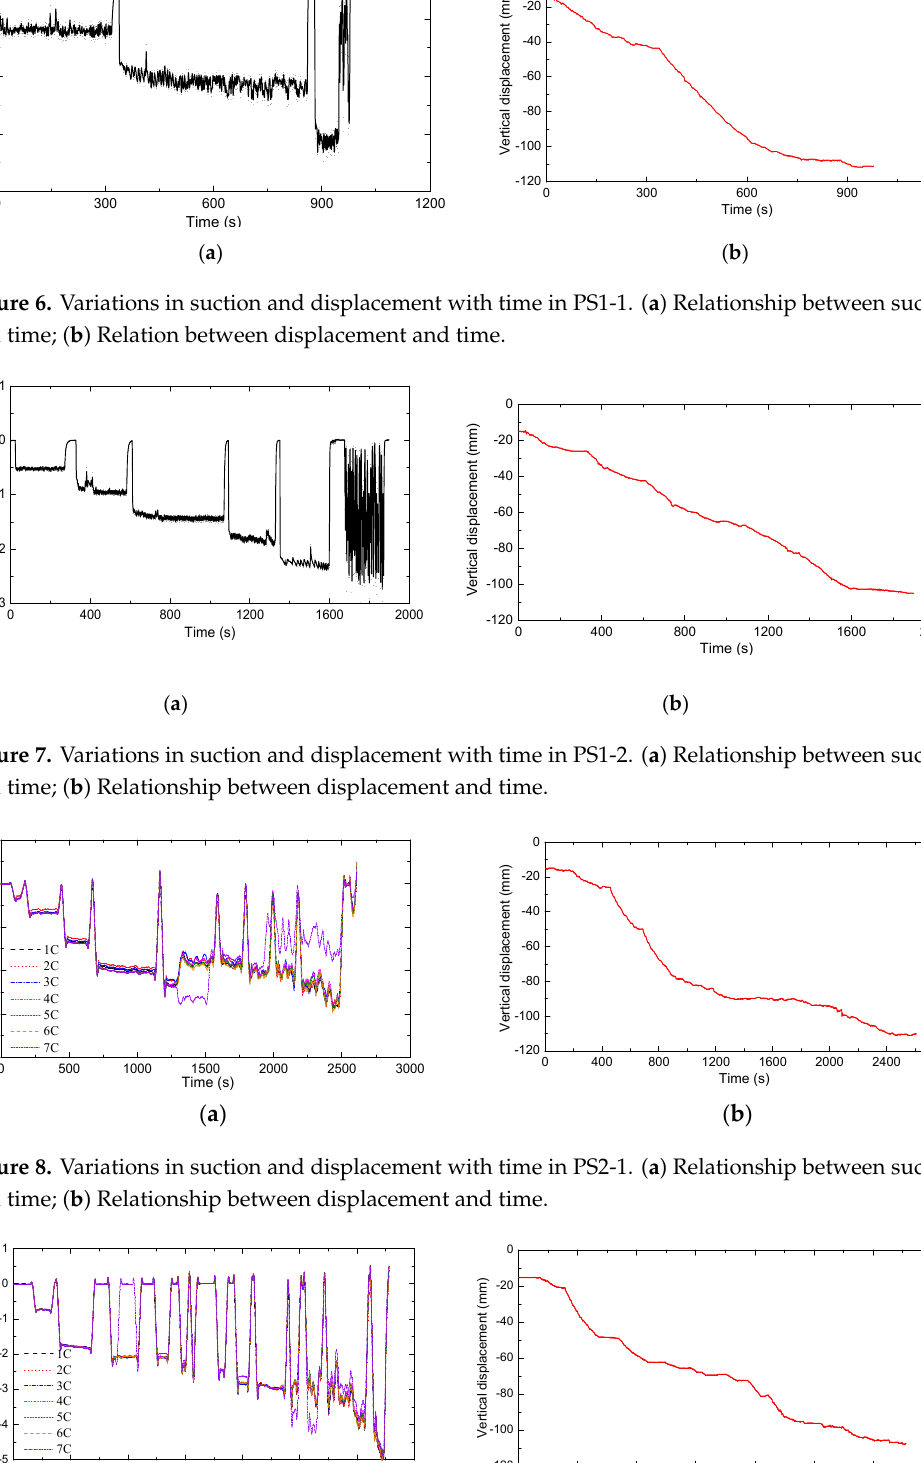
Figure 6. Variations in suction and displacement with time in PS1-1. ( a ) Relationship between suction and time; ( b ) Relation between displacement and time.